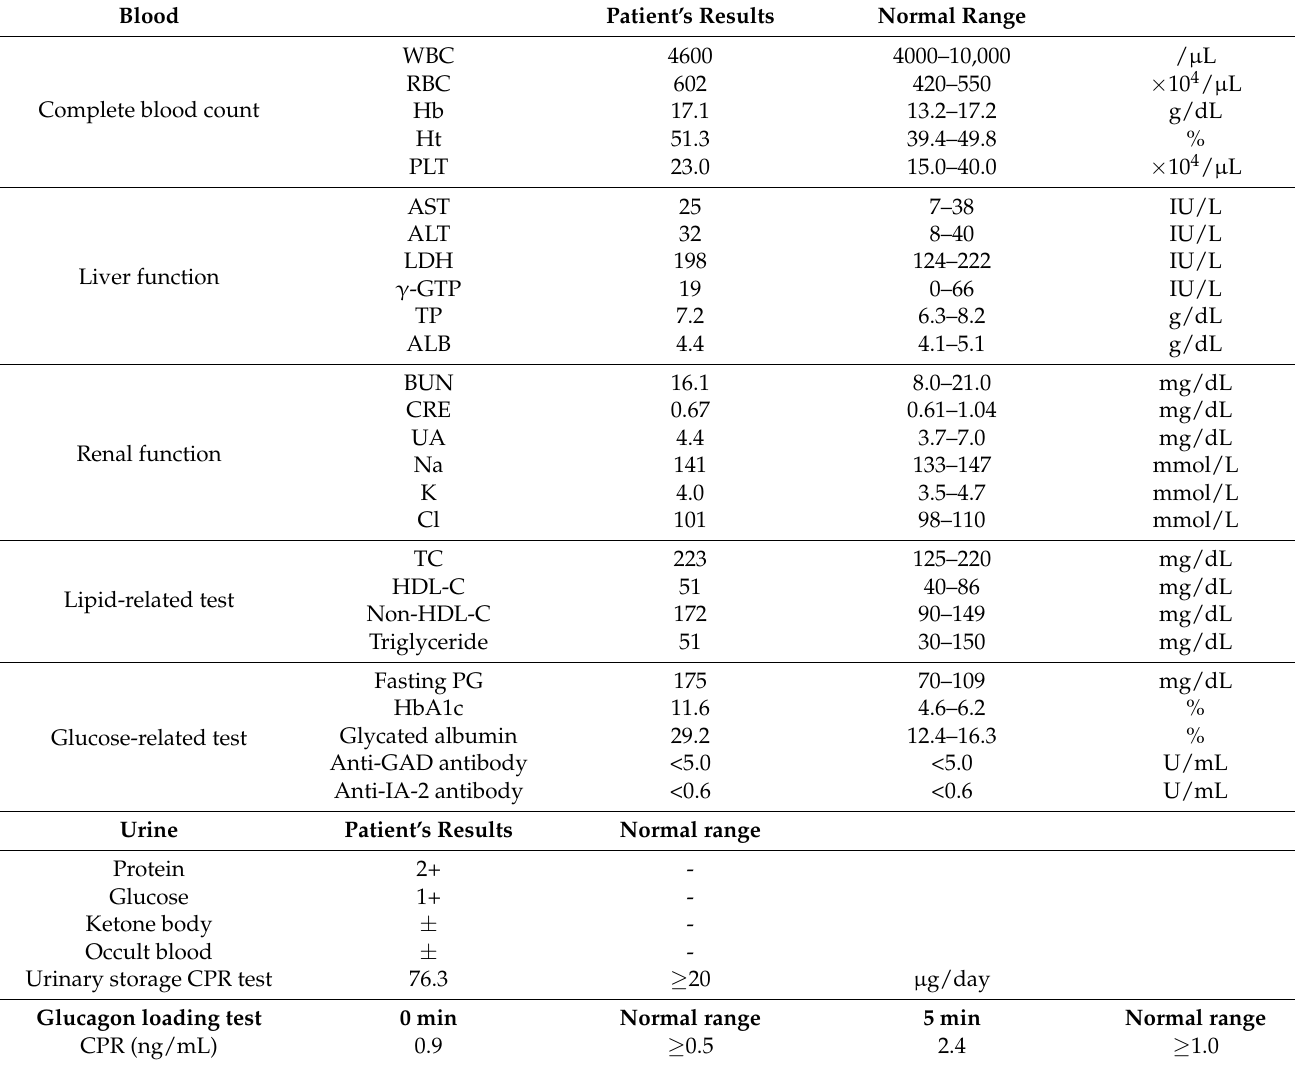
Table 1. Laboratory